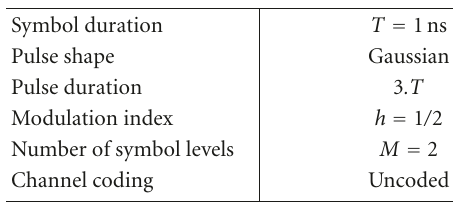
Table 6: System parameters CPM.